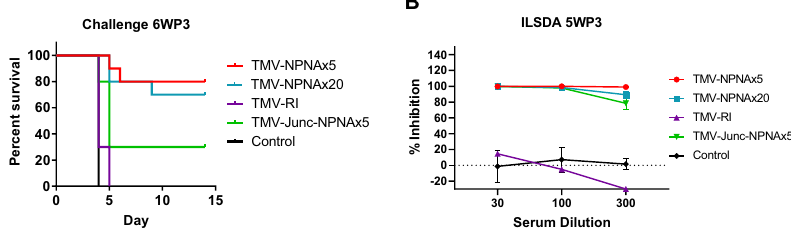
Fig. 8 Study 2 functional assessment of TMV-Junc-NPNAx5, TMV-NPNAx5, TMV-NPNAx20, and TMV-RI. A Survival curves for parasite challenge at 6WP3. B ILSDA (mean ± SEM) on serum collected 5WP3 TMV-NPNAx5 (3 experiments) TMV-NPNAx20 (3 experiments), TMV-Junc- NPNAx5 (2 experiments), and TMV-RI (1 experiment) at 1:30, 1:100, and 1:300 dilution of